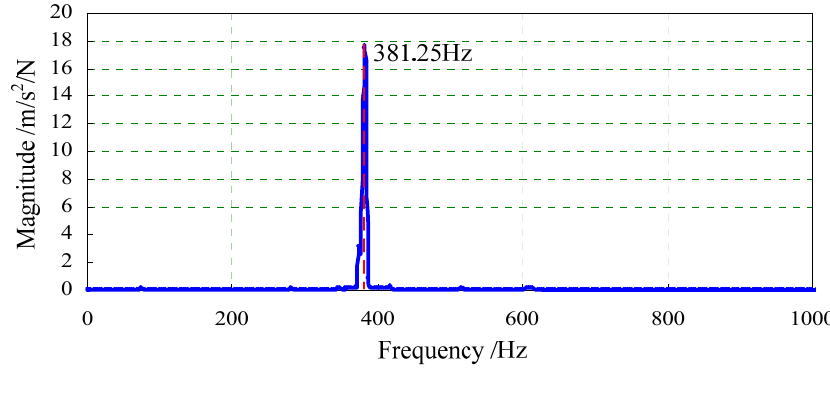
Figure 7. Frequency response of the two-axis load